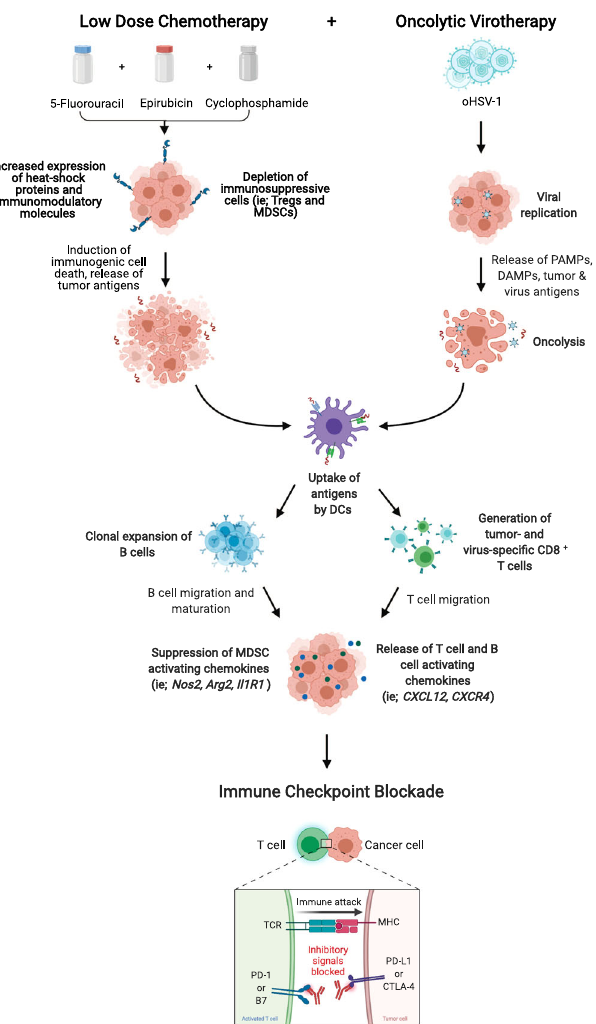
Fig. 10 Schematic of therapy-induced immune activation. *Created using